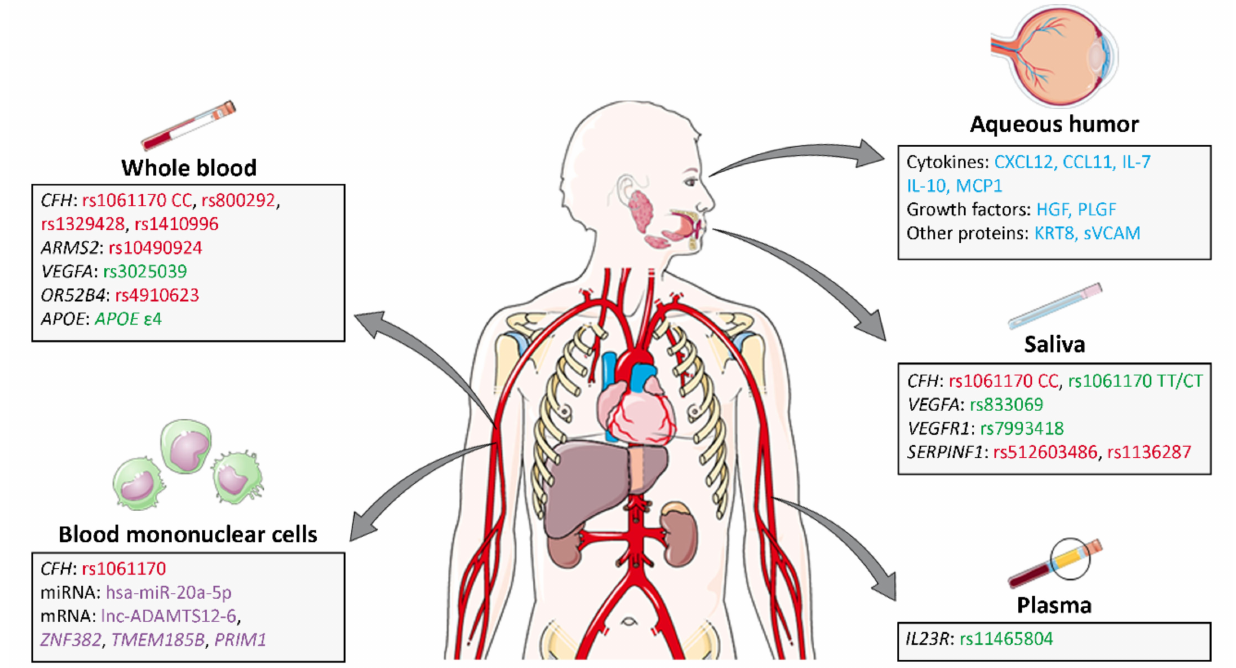
Figure 3. Summary of the main predictive biomarkers of the anti-ranibizumab treatment response described in whole blood, mononuclear blood cells, plasma, saliva and aqueous humor samples. In green, SNPs that contribute to a better anti-VEGF response; in red, SNPs associated with a worse response to anti-VEGF treatment; in blue, proteins whose levels differ between good and poor responders; in purple, mRNAs and miRNAs differently expressed in responder and non- responder patients. Images adapted from SMART Servier Medical Art (smart.servier.com, accessed on 27 March